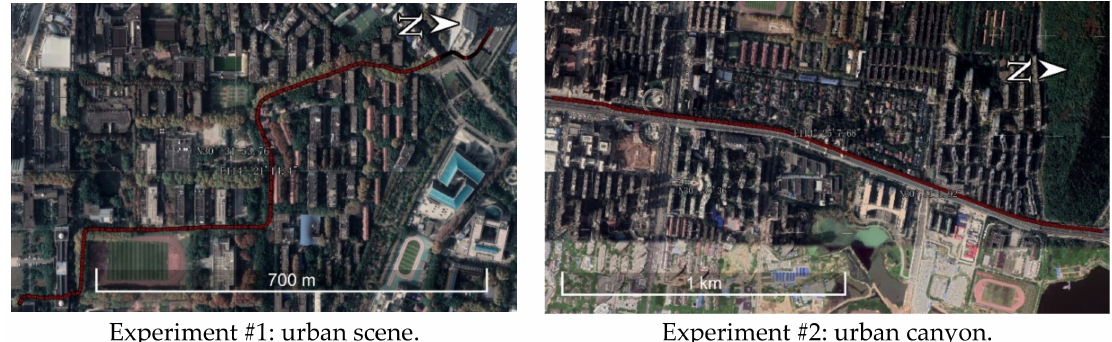
Figure 9. Map illustration of the two experiments, with the red line denoting GNSS